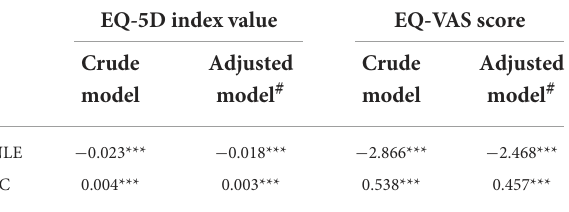
TABLE 2 Regression analyses on the association among main study